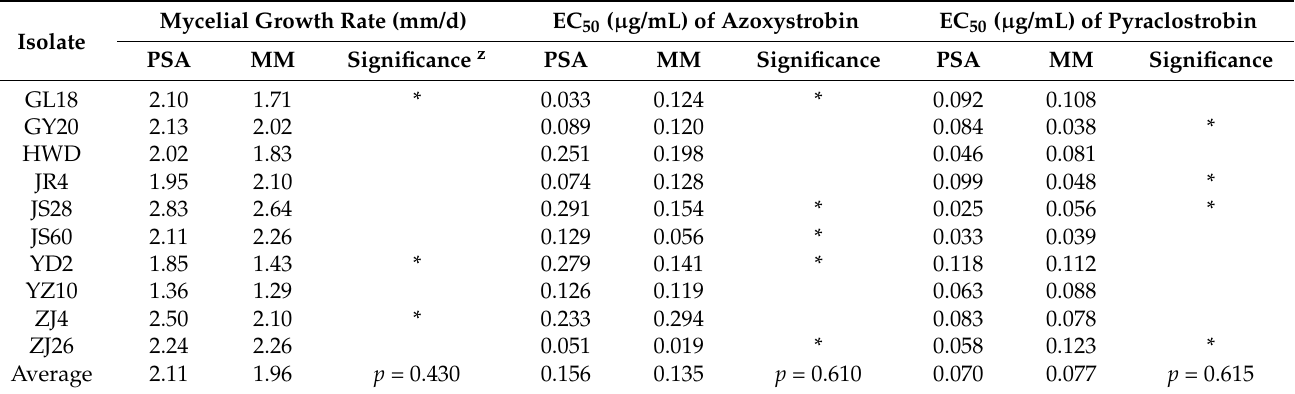
Table 1. Mycelial growth rate of U. virens and sensitivity to azoxystrobin and pyraclostrobin on potato sucrose agar (PSA) and minimal medium